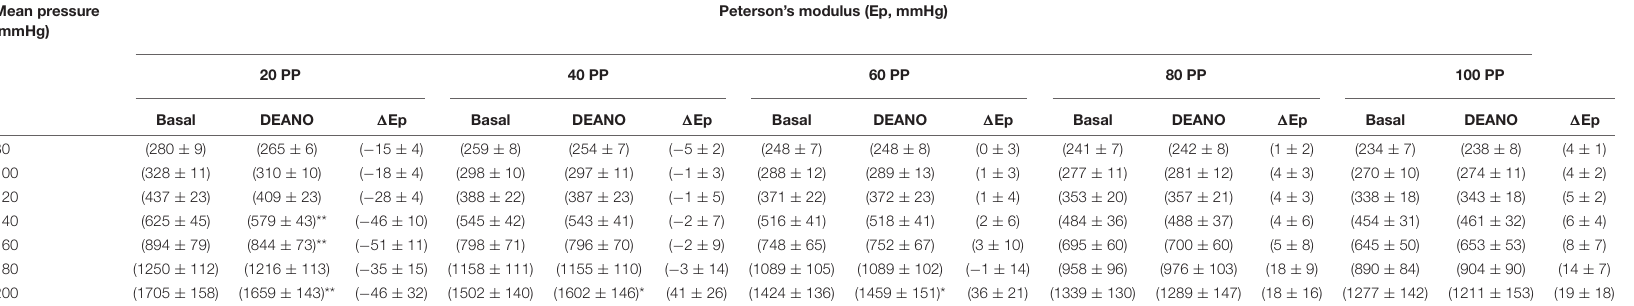
TABLE 3 | Blood vessel stiffness before and after DEANO-induced VSMC relaxation at different pulse pressures. Mean pressure